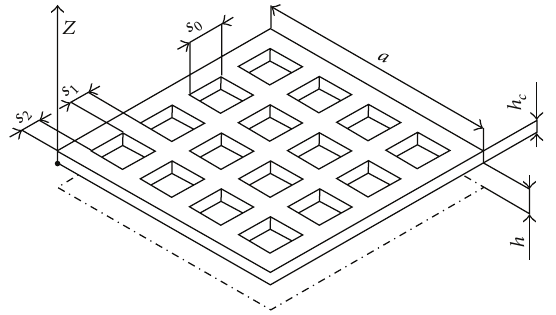
Figure 8: Schematic of the perforated microplate.